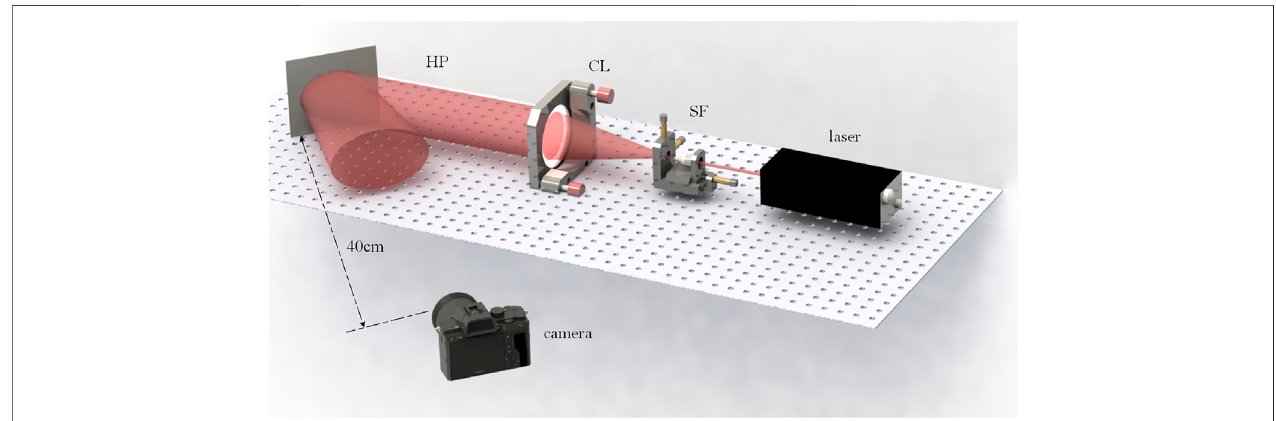
FIGURE 10 | Holographic optical reconstruction